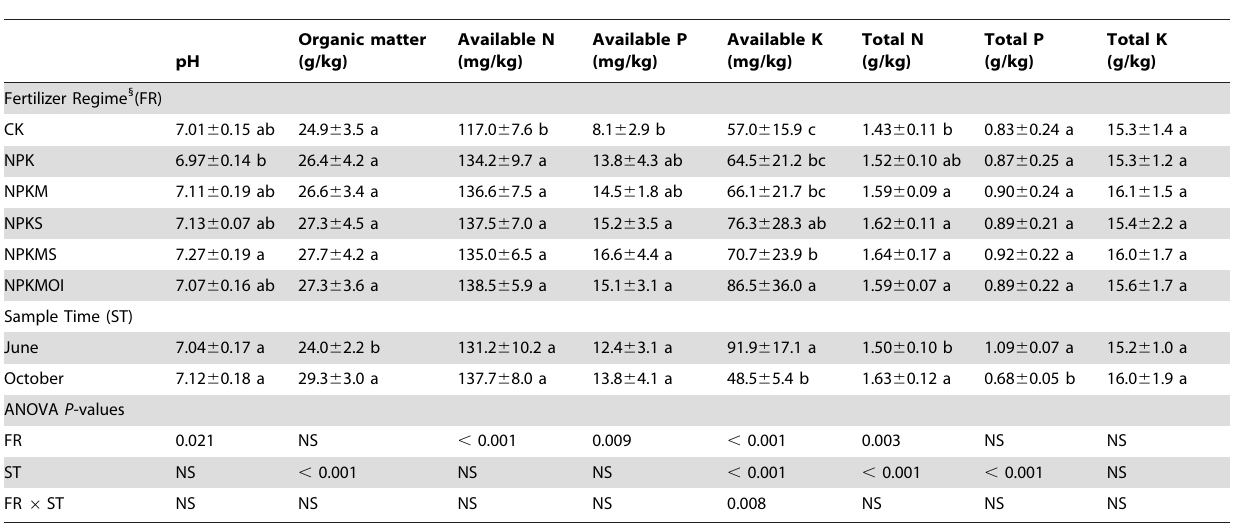
Table 1. Effects of fertilizer regime, sample time and the interaction between them on soil physicochemical characteristics.